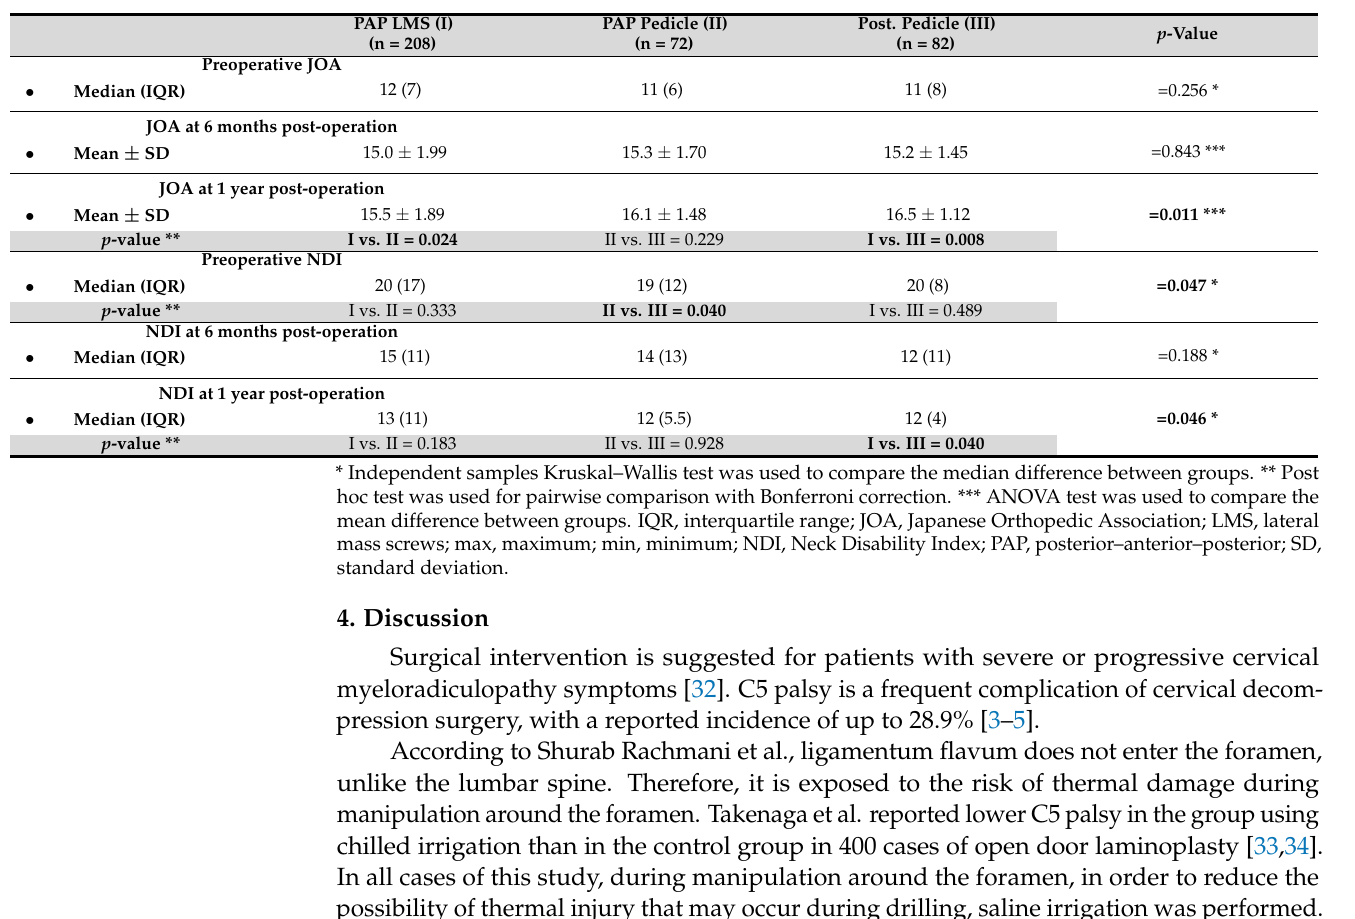
Table 4. NDI, JOA (pre- and postoperative results at 6 months and 1 year) in the studied